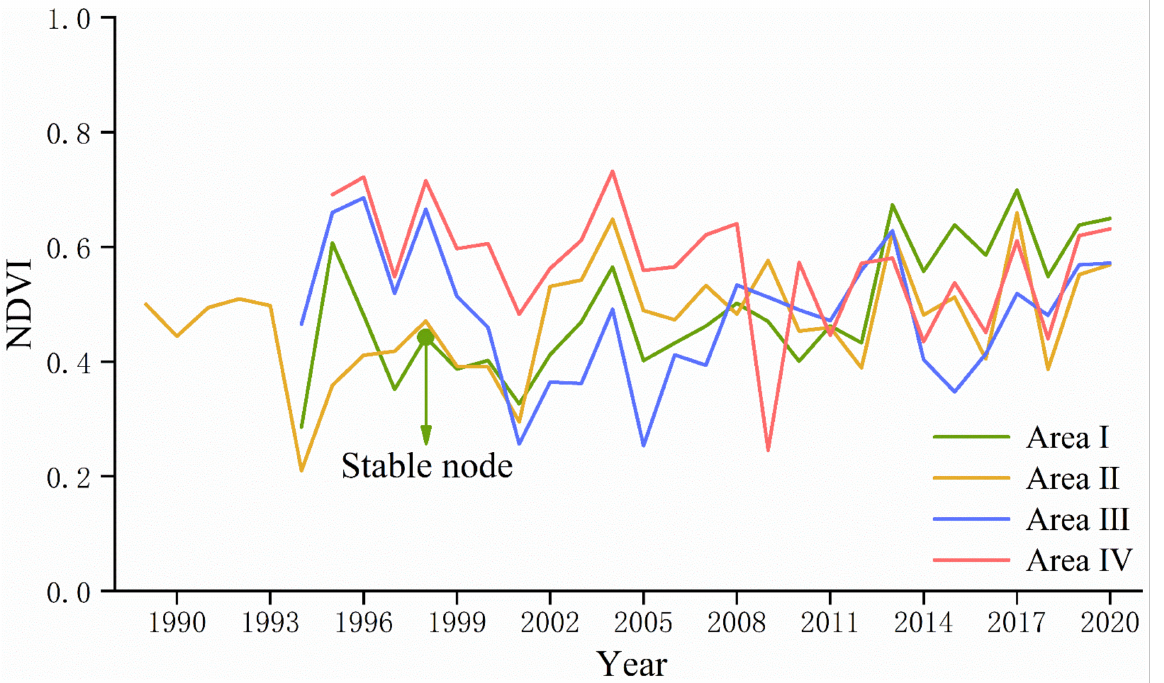
Figure 6. Annual average of NDVI in the “typical area” (area I) and the “problem areas” (areas II, III, and